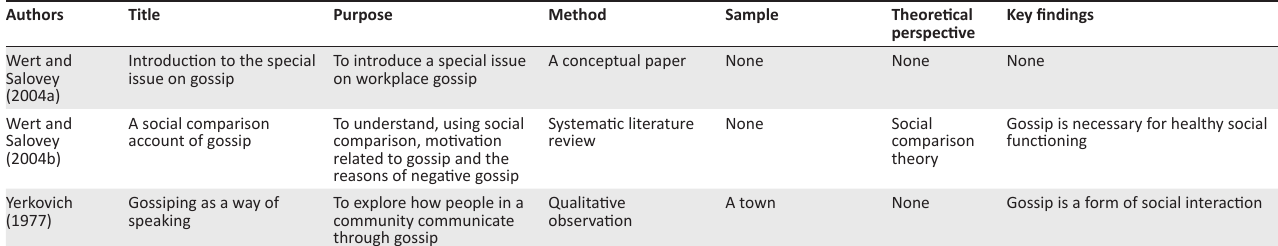
TABLE 1 (Continues...): Office gossip target articles.